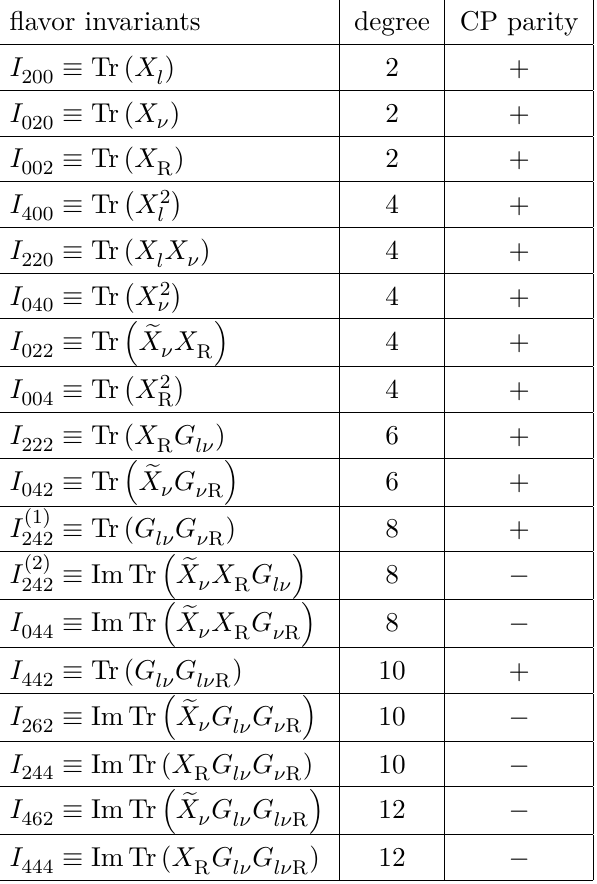
, X , e X , X ≡ Y Y † ≡ Y Y † ≡ Y † Y ≡ Y † Y ν ν ν ν ν ν R R l l R l